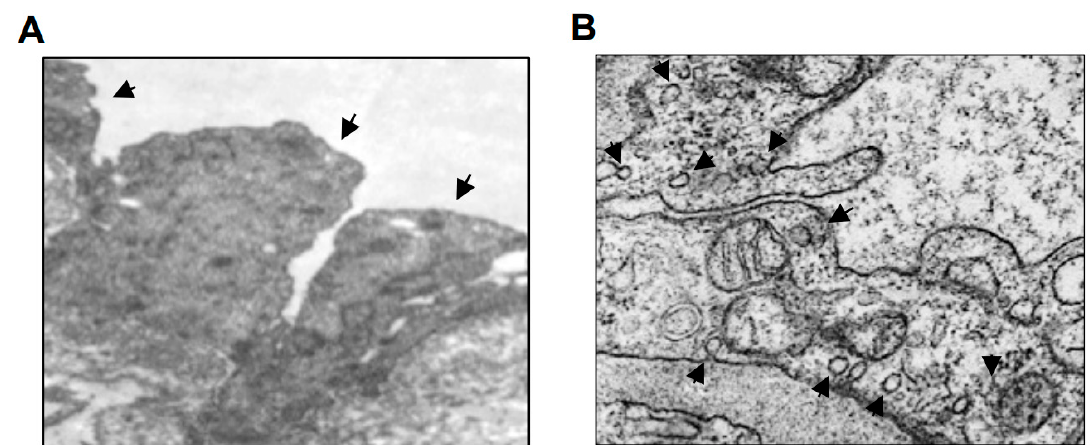
Figure 4. TEM images of the vasa vasorum of the hyalinosis lesions of the brain vessels of systemic hypertension patients. Brain tissues from systemic hypertension patients who underwent neurosurgery to remove the hematoma to treat hemorrhagic stroke were analyzed by TEM. ( A ) Arrows indicate the presence of the endothelial cell bulge. Magnification, ×5600. ( B ) Arrows indicate the presence of endocytic vesicles. Magnification, ×22,000. Representative images of n = 6